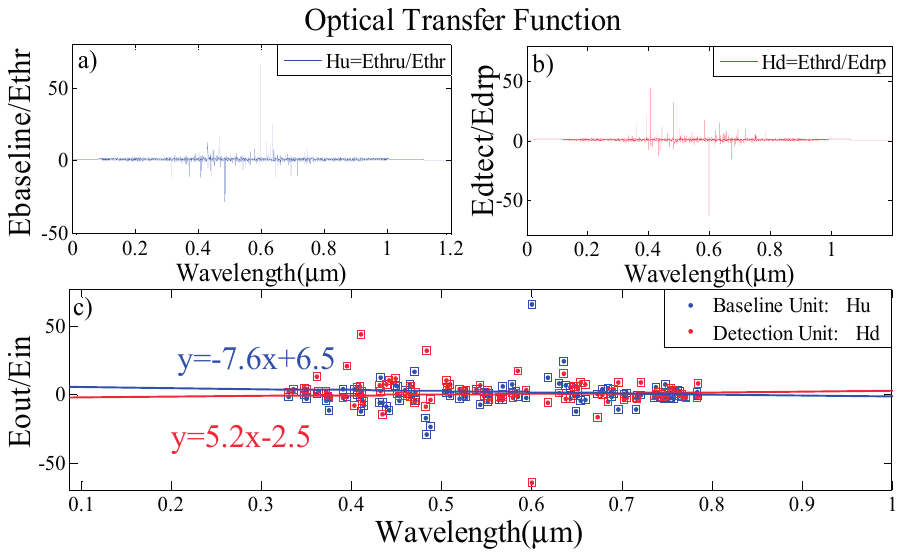
Figure 8. Optical transfer function for ( a ) base line unit ( b ) detection unit ( c ) both units with sensing